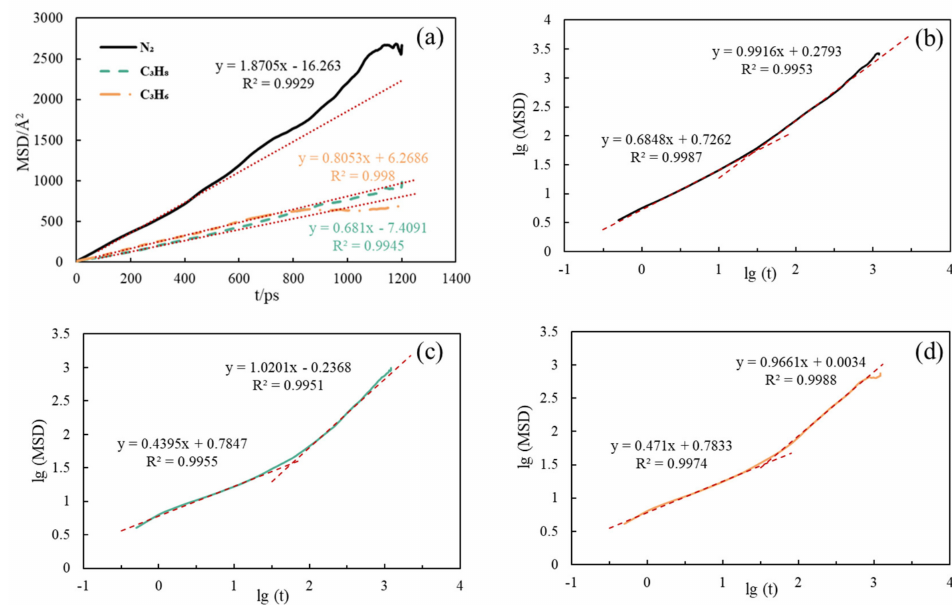
Figure 4. The MSD − t curve for the transport of C 3 /N 2 ( a ) and the lg (MSD) − lg (t) curve for the transport of N 2 ( b ), C 3 H 8 ( c ) and C 3 H 6 ( d ). Table 3. Diffusion coefficients of C 3 /N 2 as ( a ) pure gases and ( b ) mixed gases in PDMS. Pure Gas